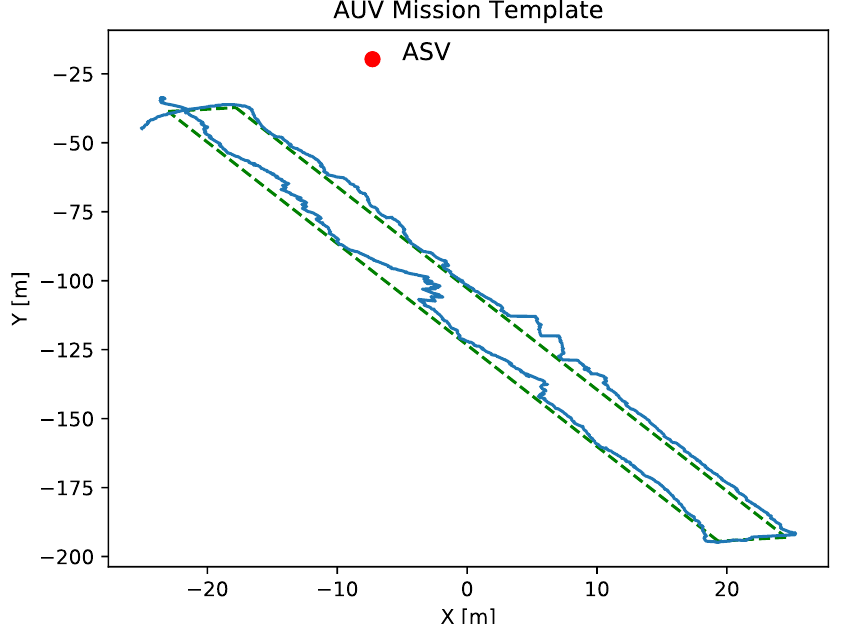
Figure 15. The green dashed line represents the programmed transect test bench for the AUV. The red dot represents the ASV static position while the blue line represents the AUV navigation during the first test execution. Table 4. Test bench mission parameters